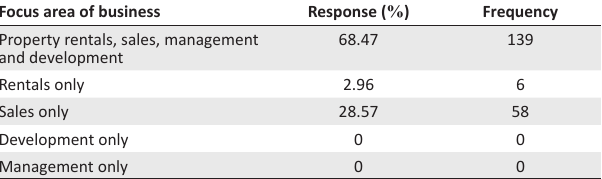
TABLE 3: Percentage response and frequency of business focus area ( N = 203).